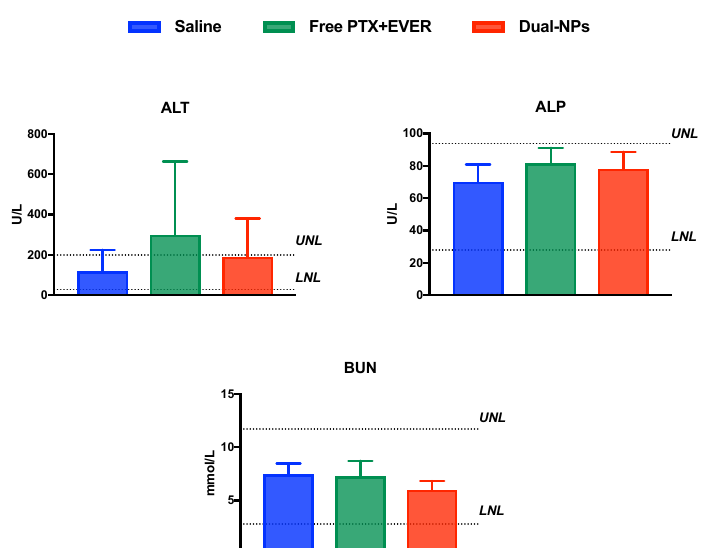
Figure 7. Alanine aminotransferase (ALT), alkaline phosphatase (ALP), and blood urea nitrogen (BUN) in mice 2–3 days after receiving saline (blue), free paclitaxel and everolimus (PTX+EVER) (green), and dual-targeted PTX+EVER-loaded nanoparticles (Dual-NPs) (red) weekly for 6 weeks at a PTX-equivalent dose of 15 mg / kg. Data represent mean ± SD ( n = 5–8).